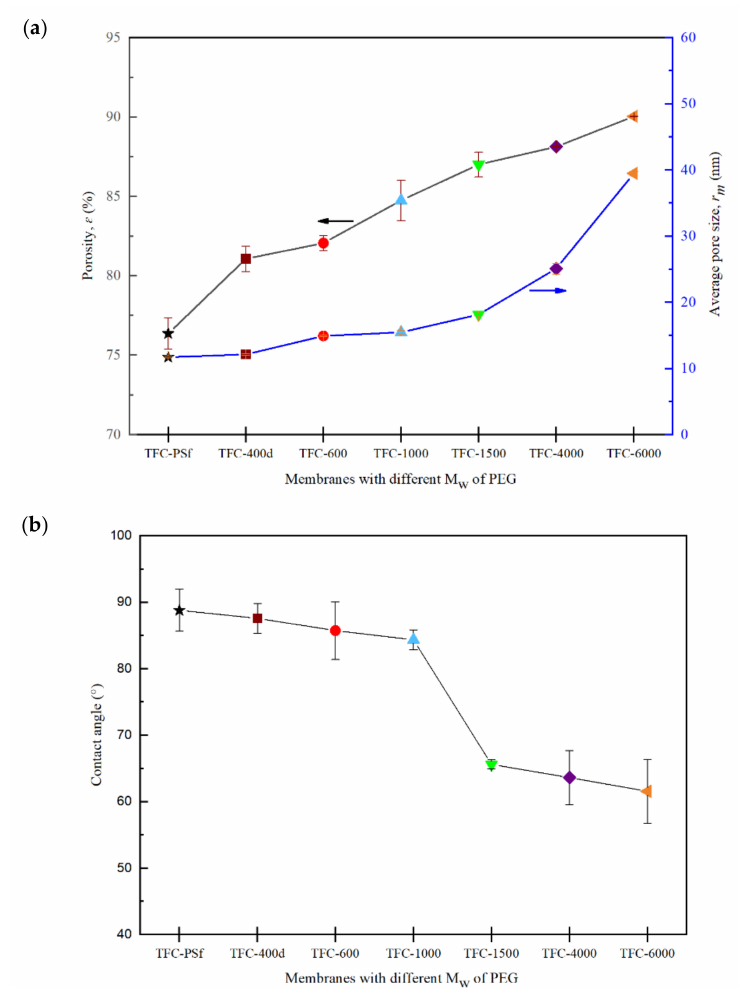
Figure 9. ( a ) Porosity, ε and average pore size, r m , and ( b ) contact angle of the modified TFC membranes with different M w of